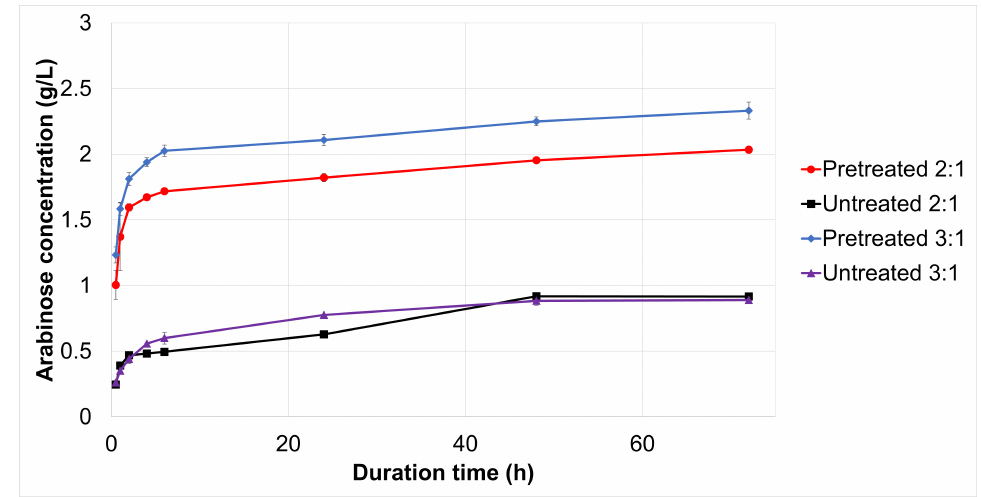
Figure 6. Arabinose concentration for untreated and pretreated corn stover. Experiments were performed for two different ratios of CTec2:HTec2